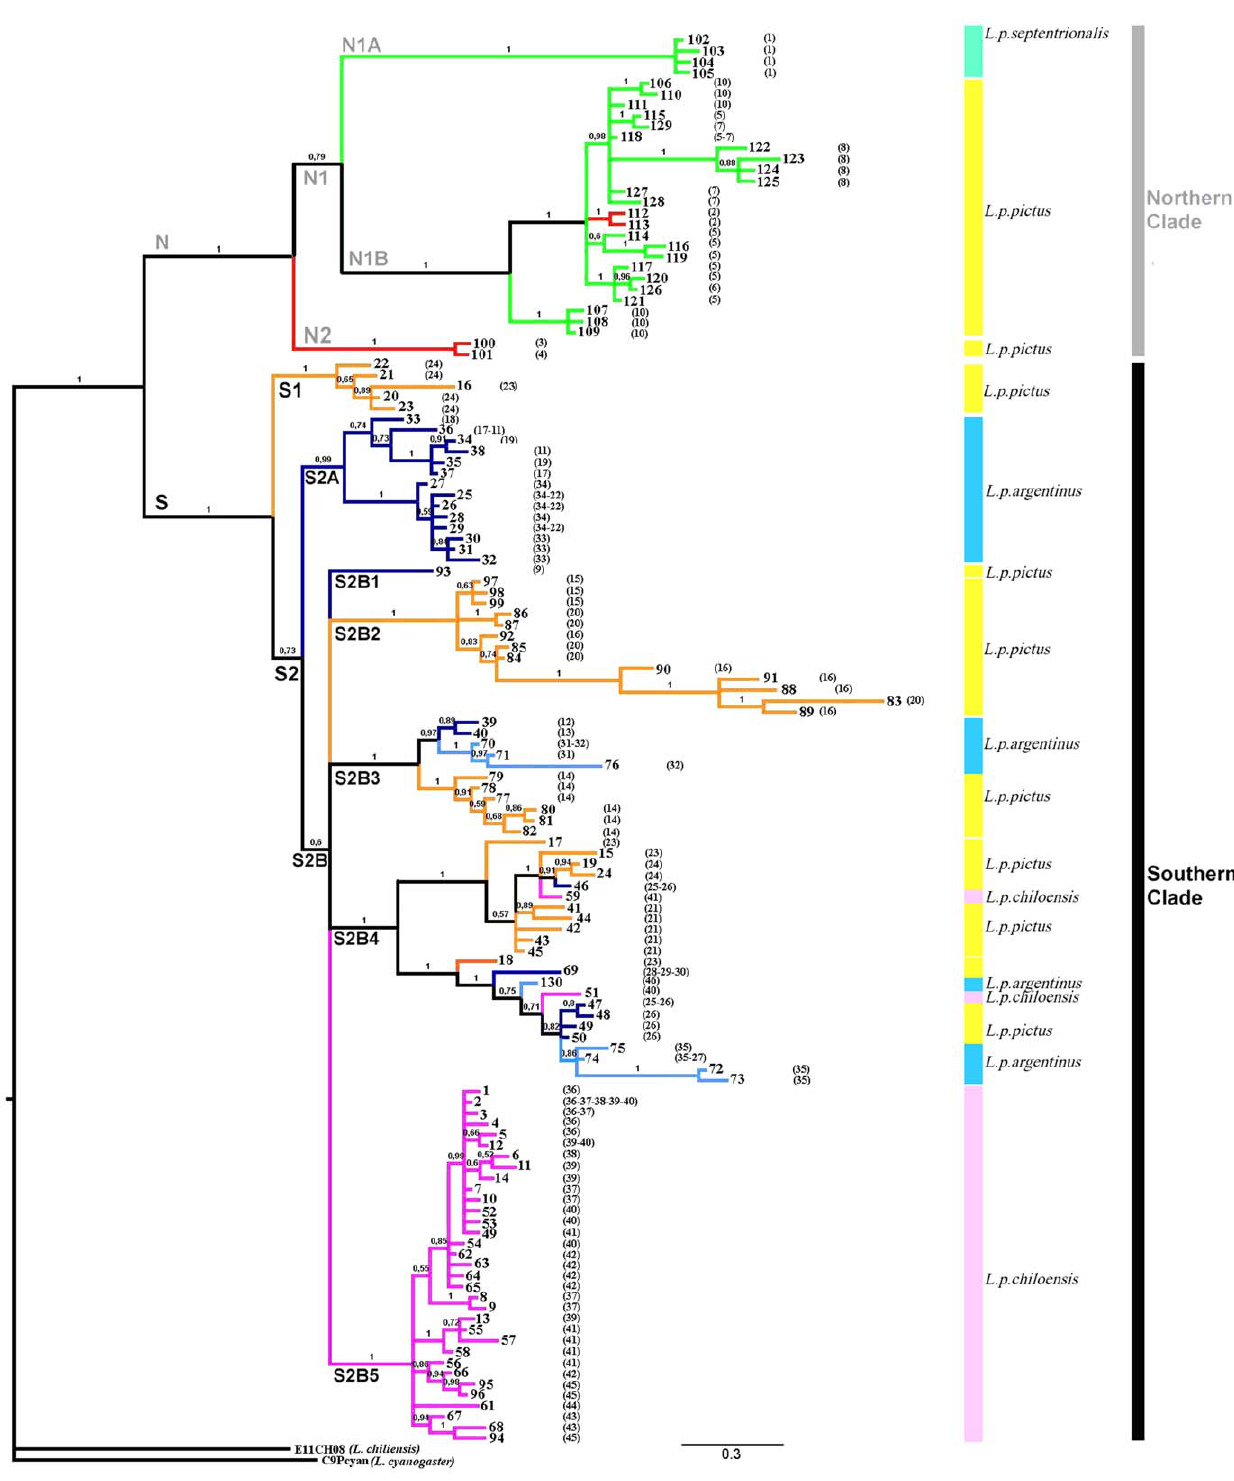
Figure 2. Cyt-b genealogy obtained in a Bayesian analysis. Branch colors as codes in the map of Fig. 1. Numbers on tips of branches correspond to haplotypes detailed in Table S2. Numbers in parentheses are localities, grey and black bars identify the two main clades, and colored bars represent the subspecies of L. pictus .